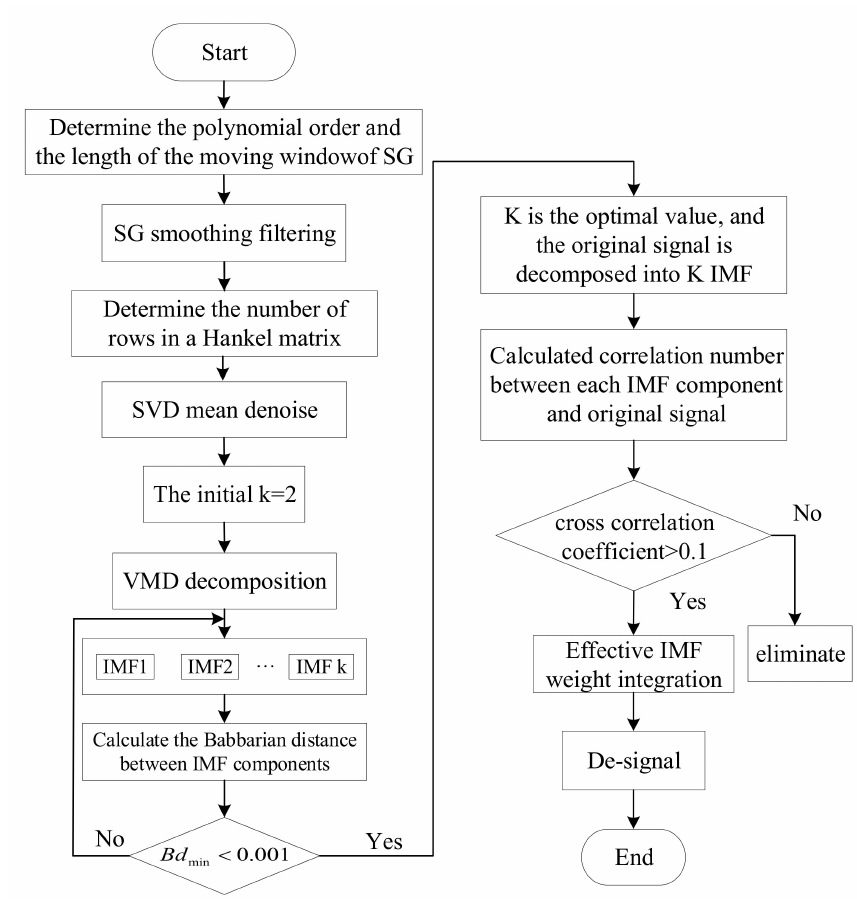
Figure 7. Signal multistage noise reduction process. Table 2. The SNR and RMSE of each signal denoising